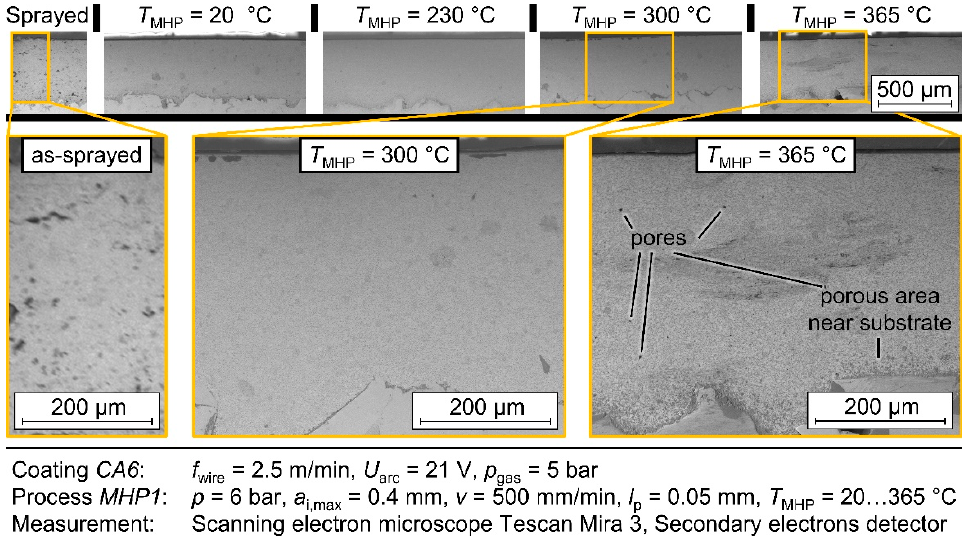
Figure 8. Scanning electron micrographs of ZnAl4 coatings in as-sprayed condition and after MHP treatment at temperatures between T MHP = 20 °C and T MHP = 365 °C using a secondary electrons detector.